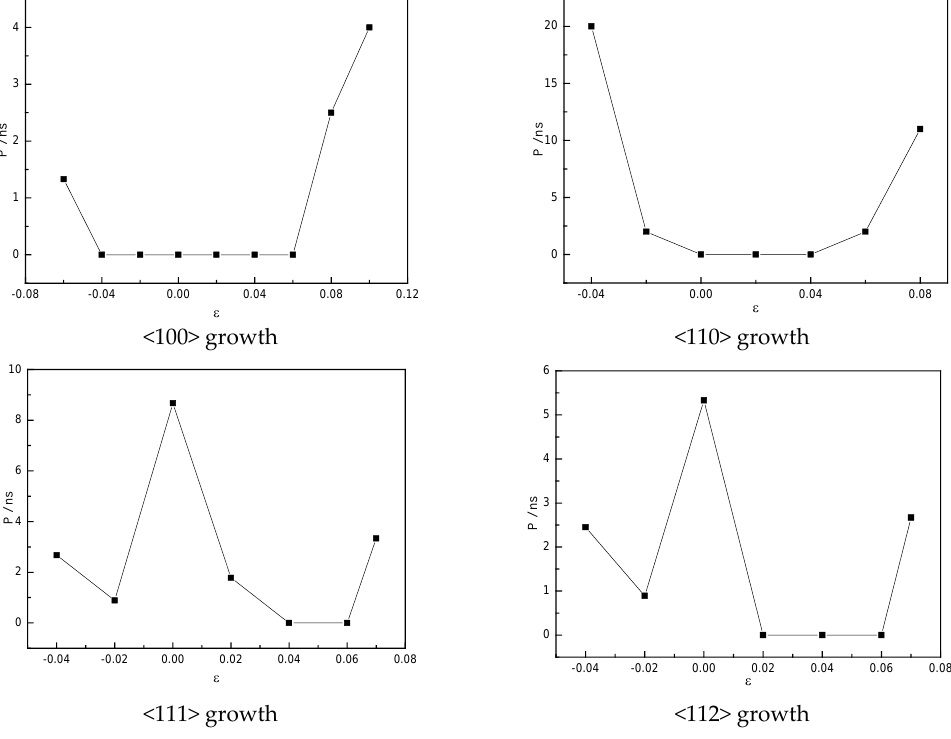
Figure 4. Probability of dislocation formation in the growth of silicon along <100>, <110>, <111> and <112>, respectively, under different strain conditions.